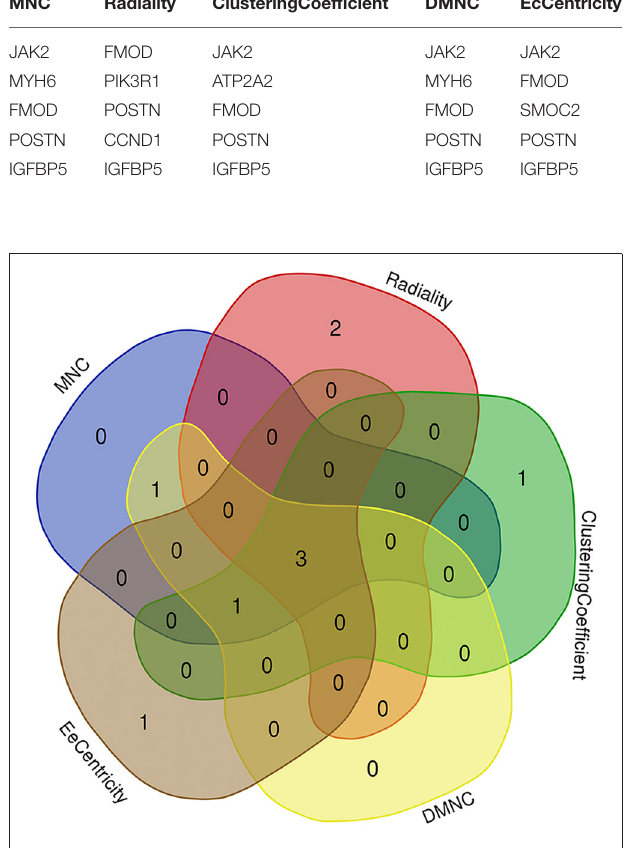
FIGURE 6 | Three hub genes were screened by overlapping the top 5 genes found by the five algorithms of